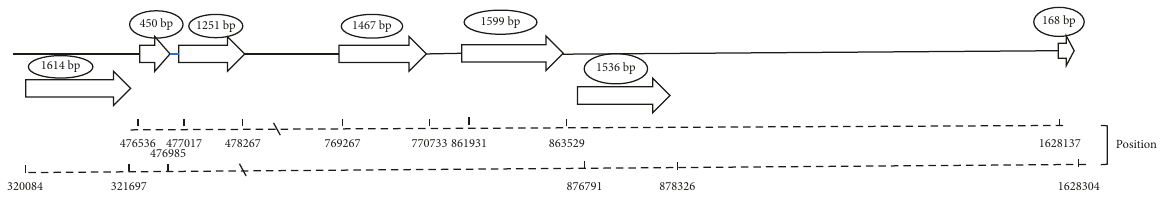
Figure 5: The gene clusters of multi-copper oxidase domain within the genome of Arthrobacter sp. PAMC25284, based on annotations in the SEED database. The arrowheads represent the genes with a start and stop position in the chromosome, along with their respective lengths.